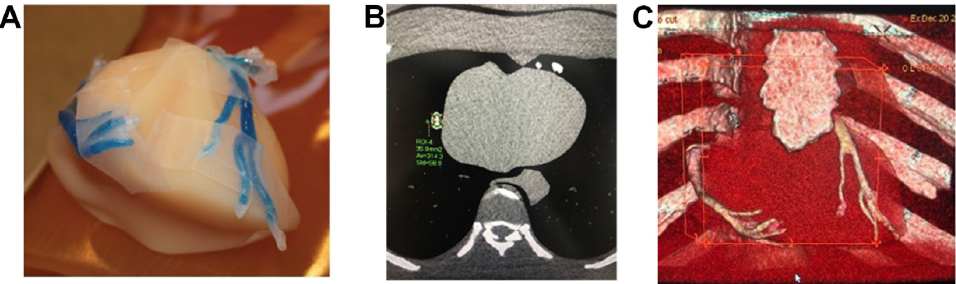
Figure 11. ( A ): Contrast-filled 3D printed coronary arteries on the Lungman. ( B ): CT image of the coronary arteries. ( C ): 3D volume rendering. Reprinted with permission under the open access from Morup et al. [82].